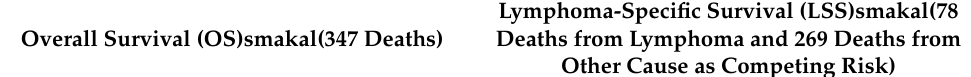
Table 3. Univariable and multivariable analyses for OS and LSS in stage I EMZL that was treated with radiation only (N =